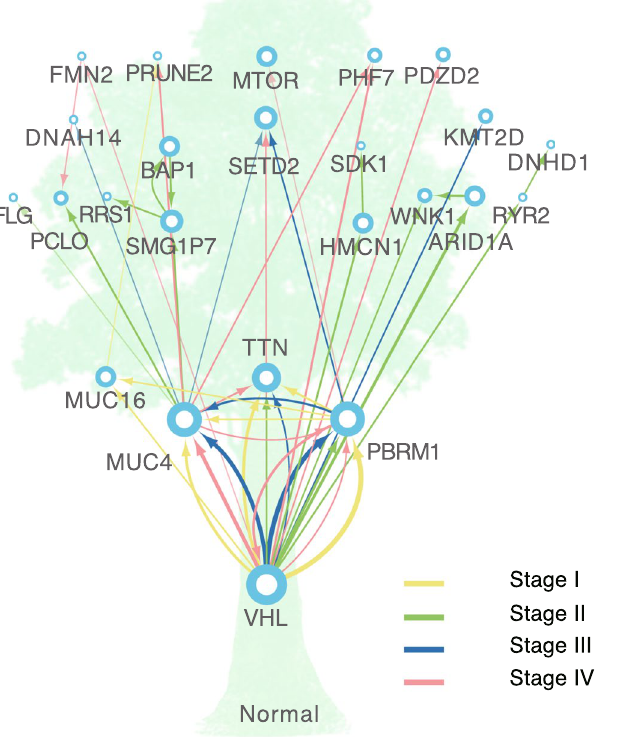
Figure 2. KIRC evolutionary path. This is a consensus graph based on evolutionary trees of each pathological stage. Line width represents the edge weights. Nodes are ordered by pathological